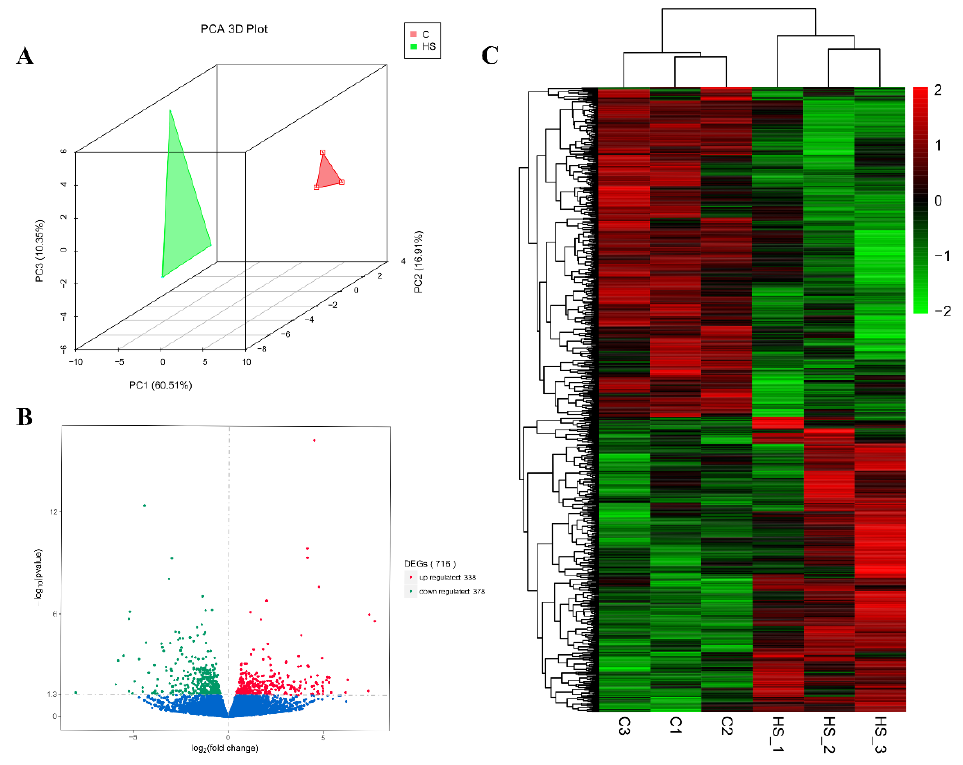
Figure 3. Differentially expressed genes (DEGs) analysis. ( A ) Principal component analysis (PCA) and heatmap analysis of the control and HS group samples. ( B ) Volcano map of DEGs in the control group and the HS group. ( C ) Hierarchical cluster analysis of DEGs.